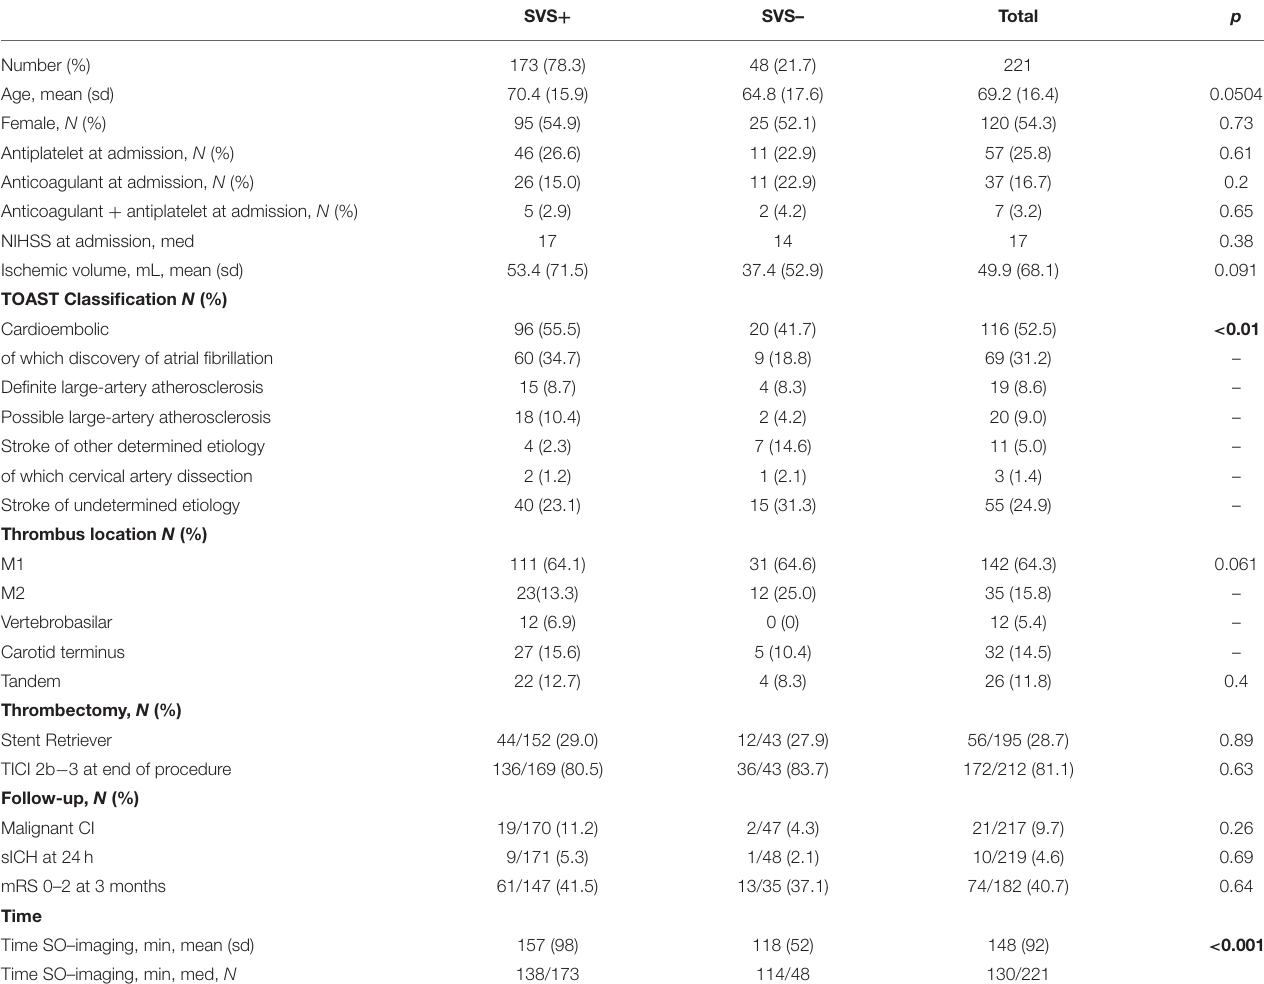
TABLE 1 | Characteristics of the subgroup with exact known symptom onset